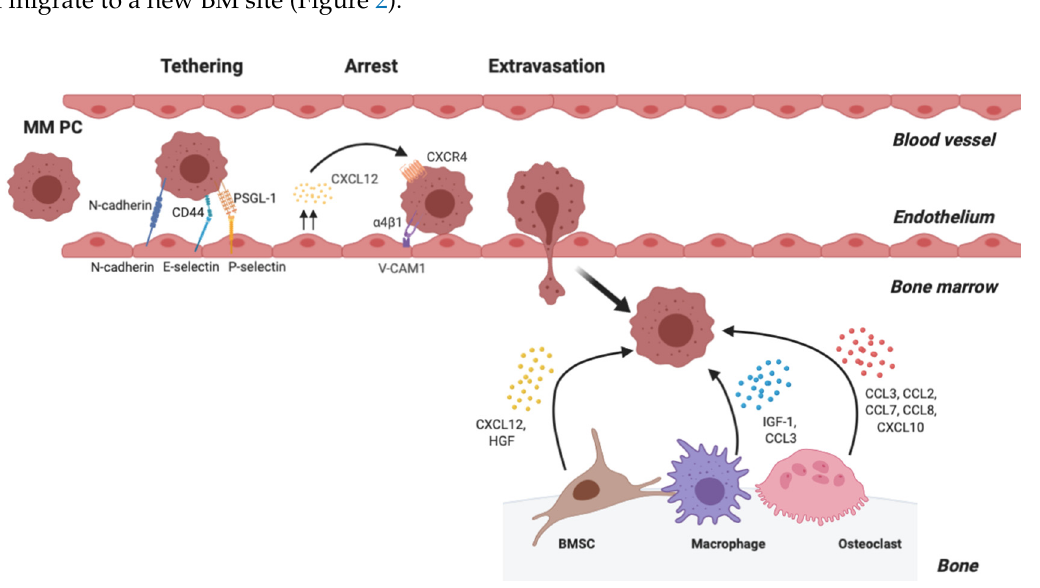
Figure 2. Multiple myeloma (MM) plasma cell (PC) extravasation is dependent on expression of key adhesion and chemoattractant molecules. Tethering and rolling are mediated by MM PC CD44 and P-selectin glycoprotein ligand-1 (PSGL-1) binding to E- and P-selectin, respectively, on endothelial cells), and homophilic adhesion of N-cadherin between MM PCs and endothelial cells. CXCL12, produced by the endothelium, activates MM PC-expressed integrin complex α 4 β 1, allowing arrest through firm adhesive interactions with VCAM-1 ligand expressed on endothelial cells. Following arrest, MM PCs undergo trans-endothelial migration following chemoattractant factors expressed within the bone marrow (BM) by BM mesenchymal stromal cells (BMSCs), macrophages and osteoclasts.